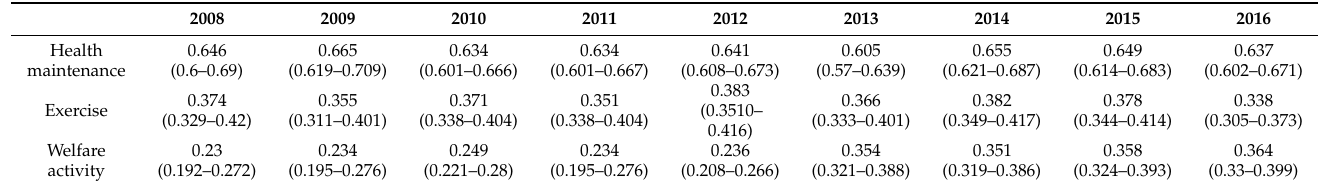
Table 3. The results of thematic analysis regarding the effectiveness and challenges of multifunc- tional autonomy.